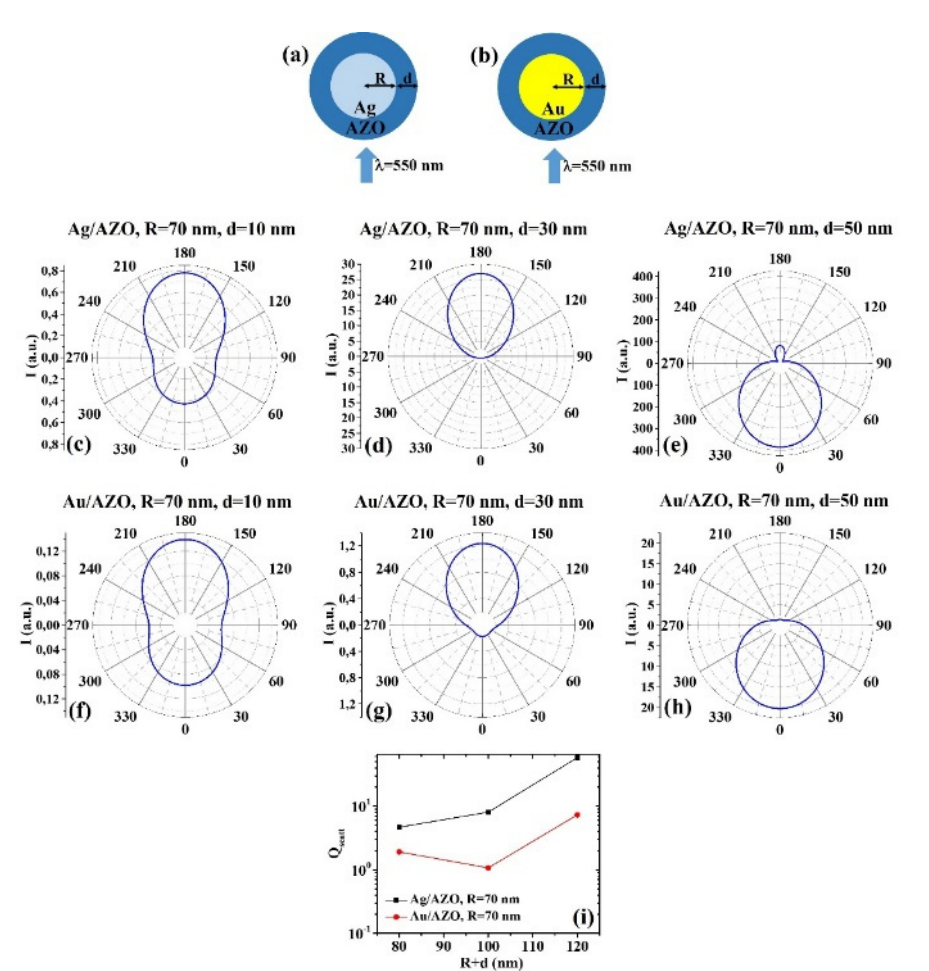
Figure 4. ( a , b ) Scheme of the structure of the simulated Ag/AZO ( a ) and Au/AZO ( b ) core–shell spherical particle with core radius R and shell width d and electromagnetic radiation of wavelength λ = 550 nm impinging on the particle from 0°. ( c – e ) Calculated polar diagrams for the intensity of the scattered light from the Ag/AZO core–shell spherical particle fixing the Ag core radius R to 70 nm and increasing the AZO shell width from 10 nm to 50 nm. ( f – h ) Calculated polar diagrams for the intensity of the scattered light from the Au/AZO core–shell spherical particle fixing the Au core radius R to 70 nm and increasing the AZO shell width from 10 nm to 50 nm. ( i ) Calculated scattering efficiency for the light (wavelength λ = 550 nm) scattering process of the Ag/AZO (black dots) and Au/AZO (red dots) core–shell spherical particles fixing the core radius to R = 70 nm and increasing the AZO shell width d from 10 nm to 50 nm.